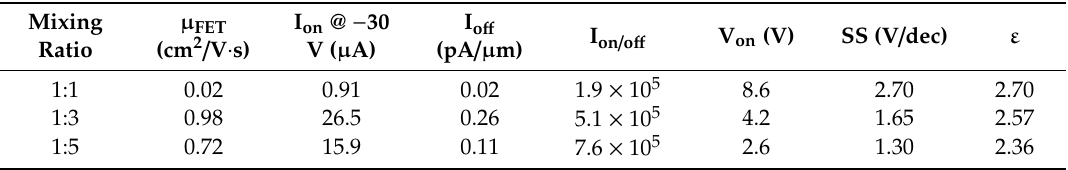
Figure 4. The transfer curves of the pentacene-OTFTs using photo-acryl (PA) for the gate dielectric with the various mixing ratios of PA to PGMEA, in which the CNT / Au (5 nm) electrodes were used for the S / D contacts. Table 1. The average values of the electrical parameters of the pentacene OTFT using photo-acryl (PA) as the gate dielectric and the CNT / Au (5 nm) electrodes for the S / D contacts according to various mixing ratios of PA to the solvent PGMEA.